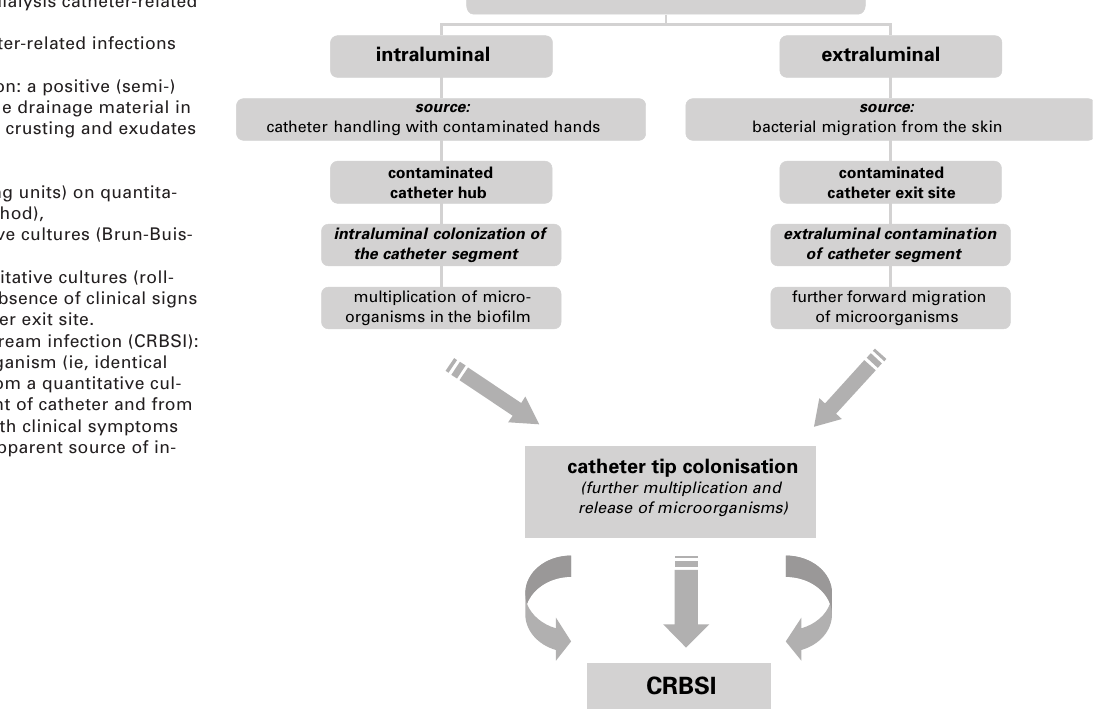
Pathogenesis of haemodialysis catheter-related bloodstream infections. CDC definitions of catheter-related infections [11]: Catheter exit-site infection: a positive (semi-) quantitative culture of the drainage material in the presence of redness, crusting and exudates at the catheter-exit site. Catheter colonisation: <10 CFUs (colony forming units) on quantita- tive cultures (vortex method), <100 CFUs on quantitative cultures (Brun-Buis- son method) or <15 CFUs on semi-quantitative cultures (roll- plate technique) in the absence of clinical signs of infection at the catheter exit site. Catheter-related bloodstream infection (CRBSI): the isolation of same organism (ie, identical species, antibiogram) from a quantitative cul- ture of the distal segment of catheter and from the blood of a patient with clinical symptoms of sepsis and no other apparent source of in-